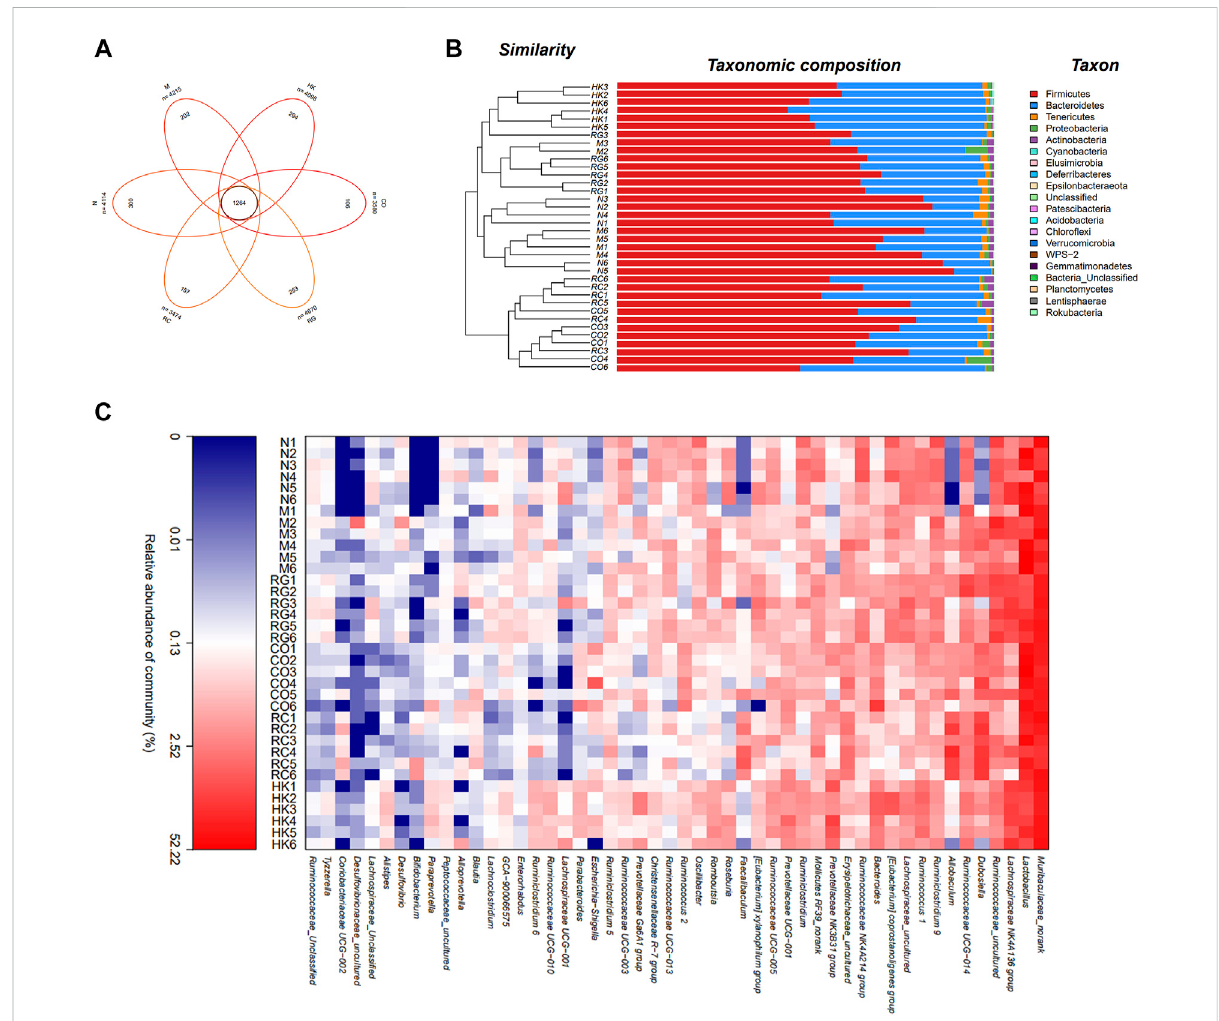
FIGURE 7 Intestinal bacterial composition of CKD rats. (A) OTU Venn analysis, (B) microbial community barplot with cluster tree, and (C) microbial community heatmap